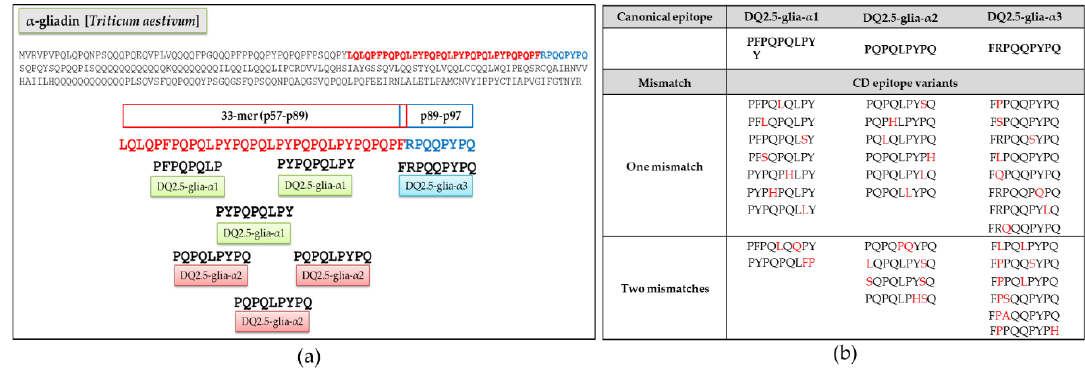
Figure 2. Celiac disease (CD) epitopes and variants derived from α -gliadin. ( a ) Location of canonical epitopes DQ-2.5-glia- α 1, DQ-2.5-glia- α 2, and DQ-2.5-glia- α 3 into α -gliadin protein. ( b ) Variants of the canonical CD epitopes with one or two mismatches selected with more than 80 reads found in Triticum and Aegilops ssp. The mismatches are indicated in red.